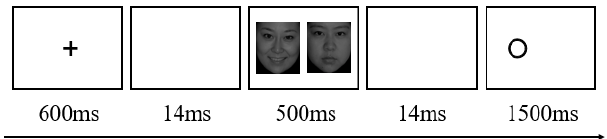
Figure 3. An illustrative example of the attention bias experiment.